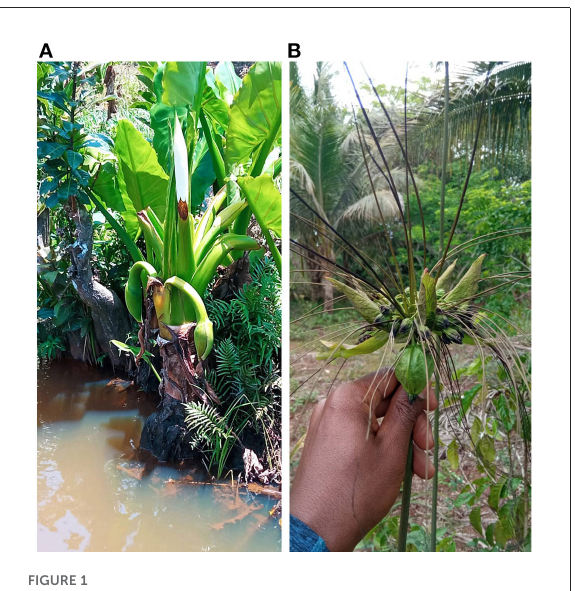
FIGURE1 (A) Via plant, (B) Tavolo